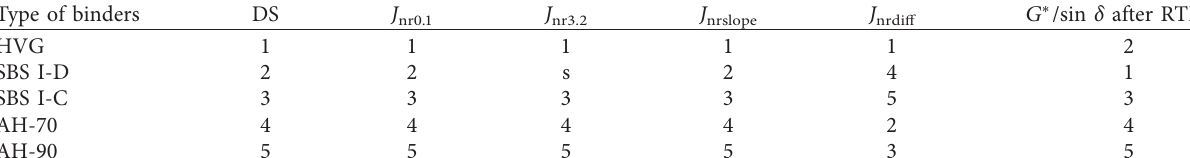
Table 6: Ranking of rutting resistance based on rutting test results at 60 ° C; MSCR and DSR results at 64 ° C. Type of